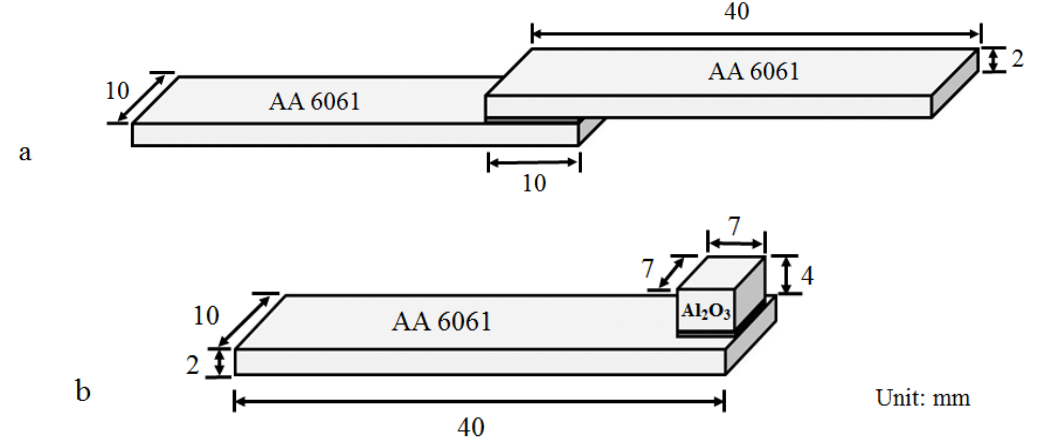
Figure 1. The geometry of the ( a ) AA6061/AA6061 and ( b ) AA6061/alumina joined specimens subjected to shear testing.